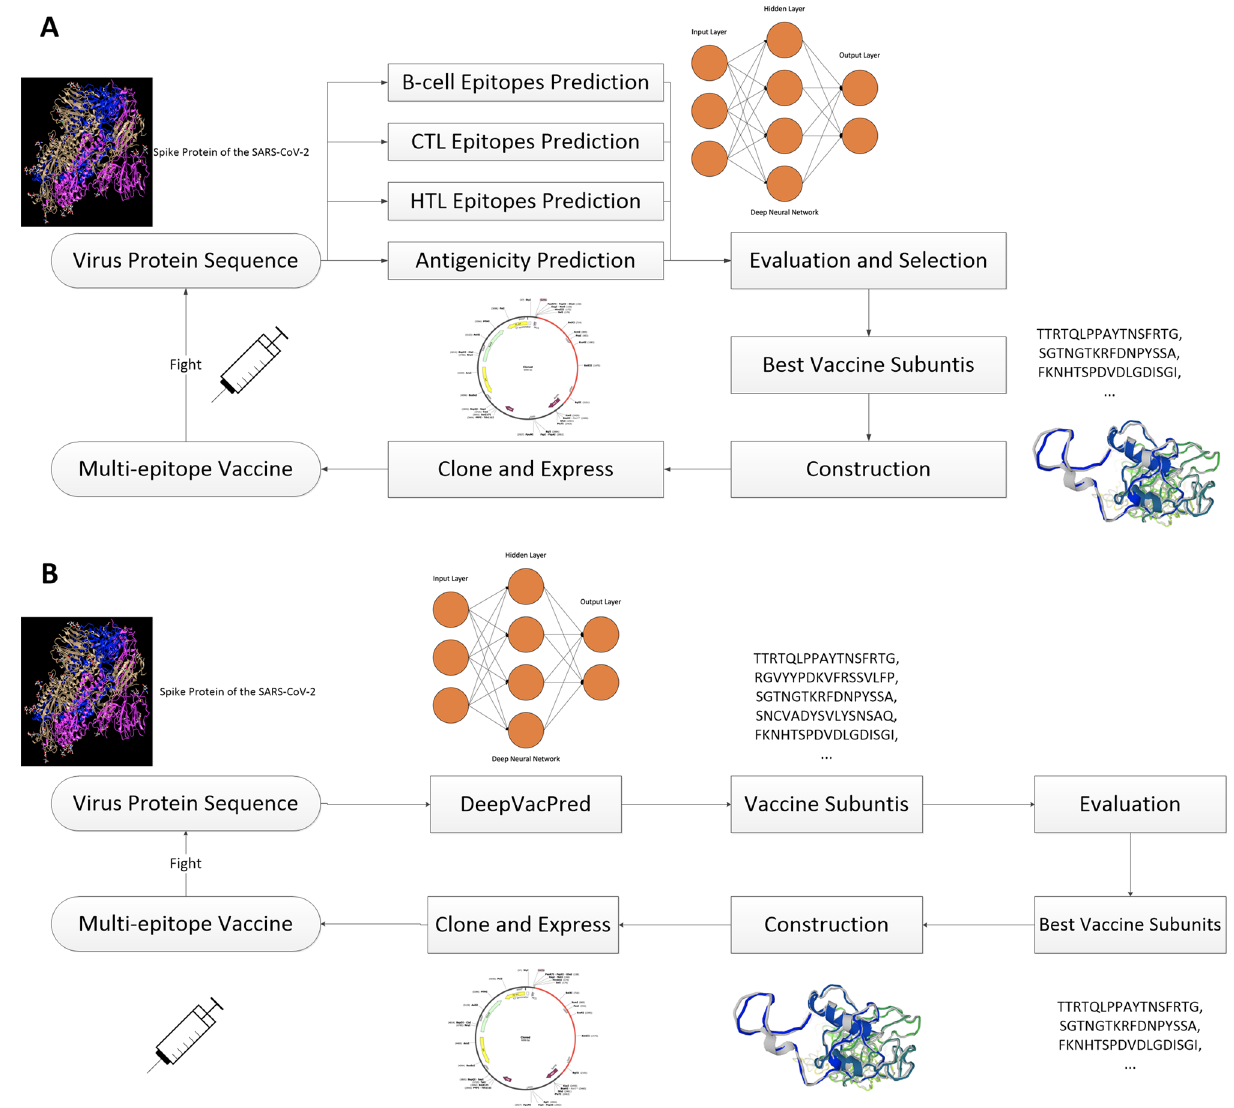
Figure 1. Schematic Diagram of In Silico Vaccine Design Process. (A) Traditional in silico vaccine design process. We have to use numerous vaccine design tools. The evaluation and subunits selection is very time consuming. No current tool is able to include all the predictions to comprehensively analyze and select out the best vaccine subunits directly. (B) In silico vaccine design by DeepVacPred framework. By replacing the many predictions, evaluations and selections with a DNN architecture inside the DeepVacPred framework, we are able to directly predict a very small number of potential vaccine subunits within a second and start the following evaluation and vaccine construction on a much smaller amount of